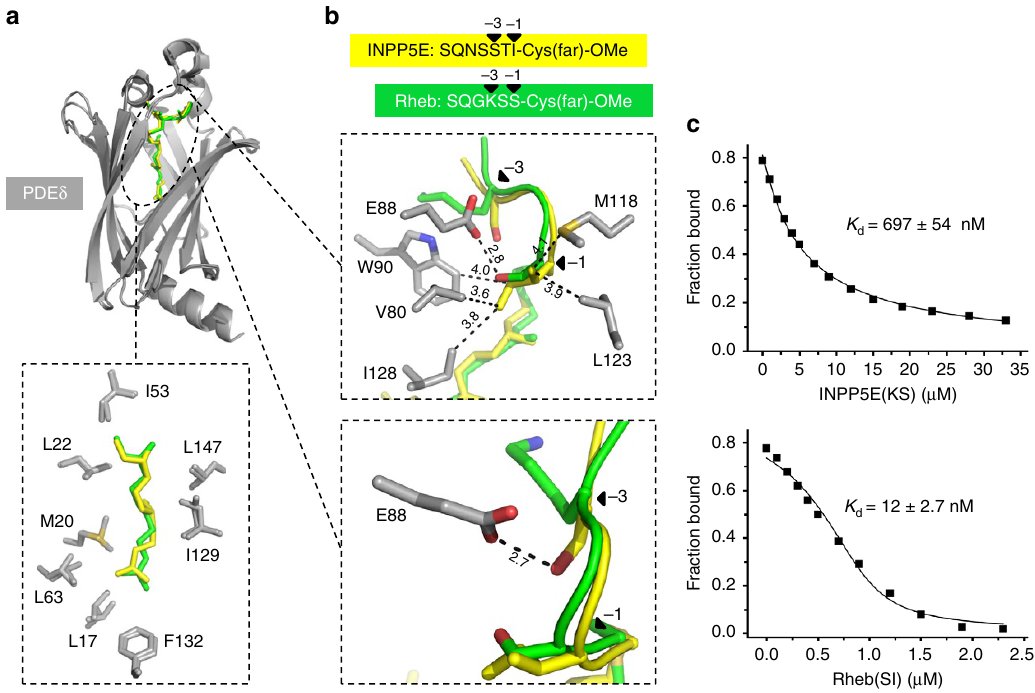
Figure 4 | Structural analysis of the interaction between PDE6 d and farnesylated cargo. ( a ) Superimposition of farnesylated INPP5E peptide-PDE6 d and Rheb-PDE6 d (PDB code: 3T5G). The farnesyl moieties of INPP5E (yellow) and Rheb (green) insert into the hydrophobic pocket of PDE6 d (grey) (upper) and maintain the same interaction pattern with the surrounding hydrophobic residues of PDE6 d (lower). ( b ) Differences in the interaction pattern at the (cid:2) 1 (upper) and (cid:2) 3 (lower) residues from Rheb (green) and INPP5E (yellow) with PDE6 d , bond lengths (black dashed line) are given in Å. ( c ) Titrations of a complex between 0.5 m M FITC-labelled Rheb peptide and 1 m M PDE6 d with increasing concentrations of INPP5E(KS) (upper) and Rheb(SI) (lower) mutant peptides. Titration data were fitted with a competition model. ± indicates s.d. ( n Z 12).